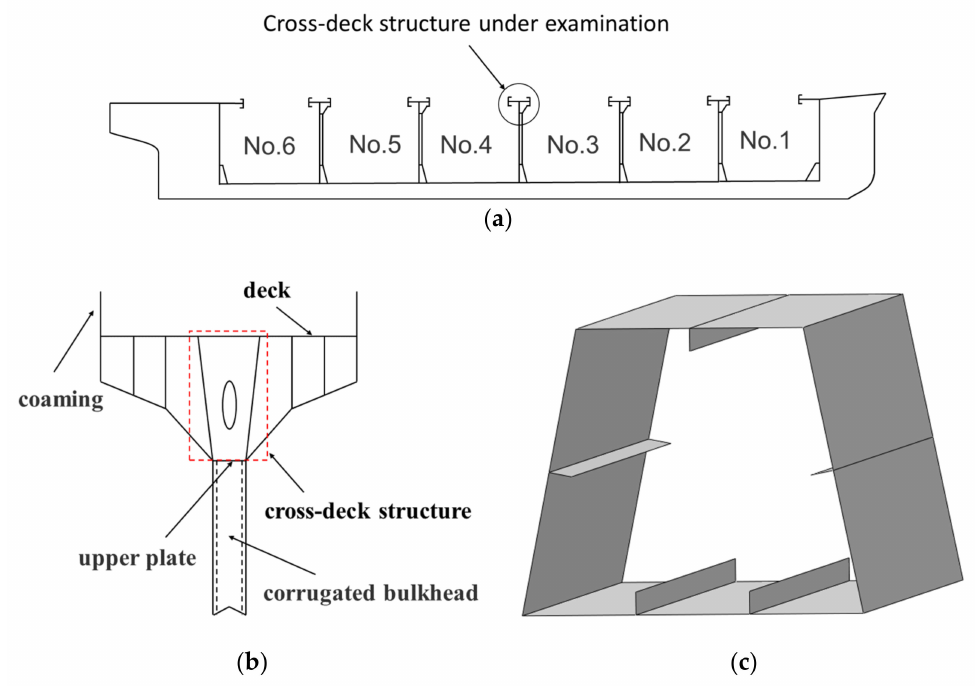
Figure 1. Cross-deck structure and its simplified model ( a ) The position of cross-deck structure in ships. ( b ) Schematic diagram of cross-deck structure ( c ) Simulation model of cross-deck structure.